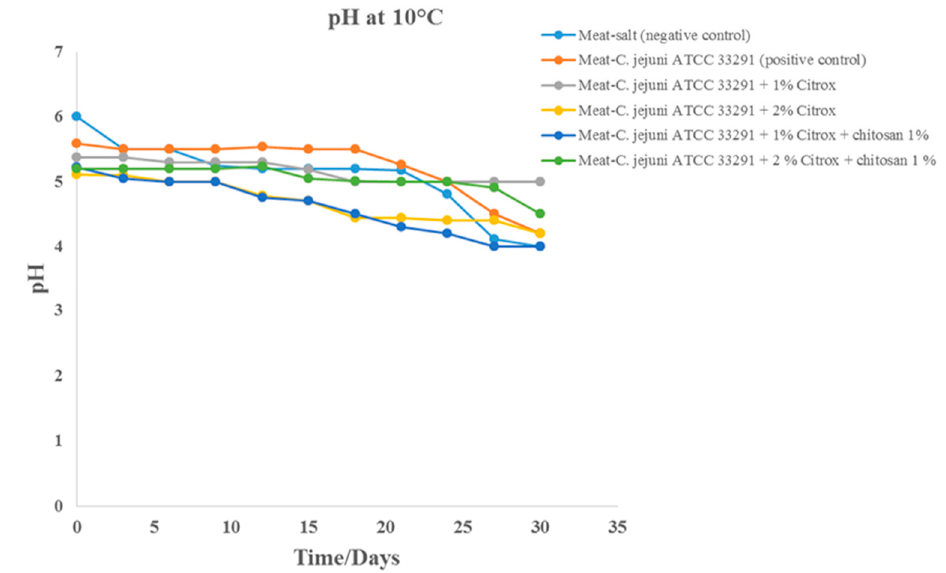
Figure 5. pH values of camel meat samples during storage at 10 °C for 30 days.